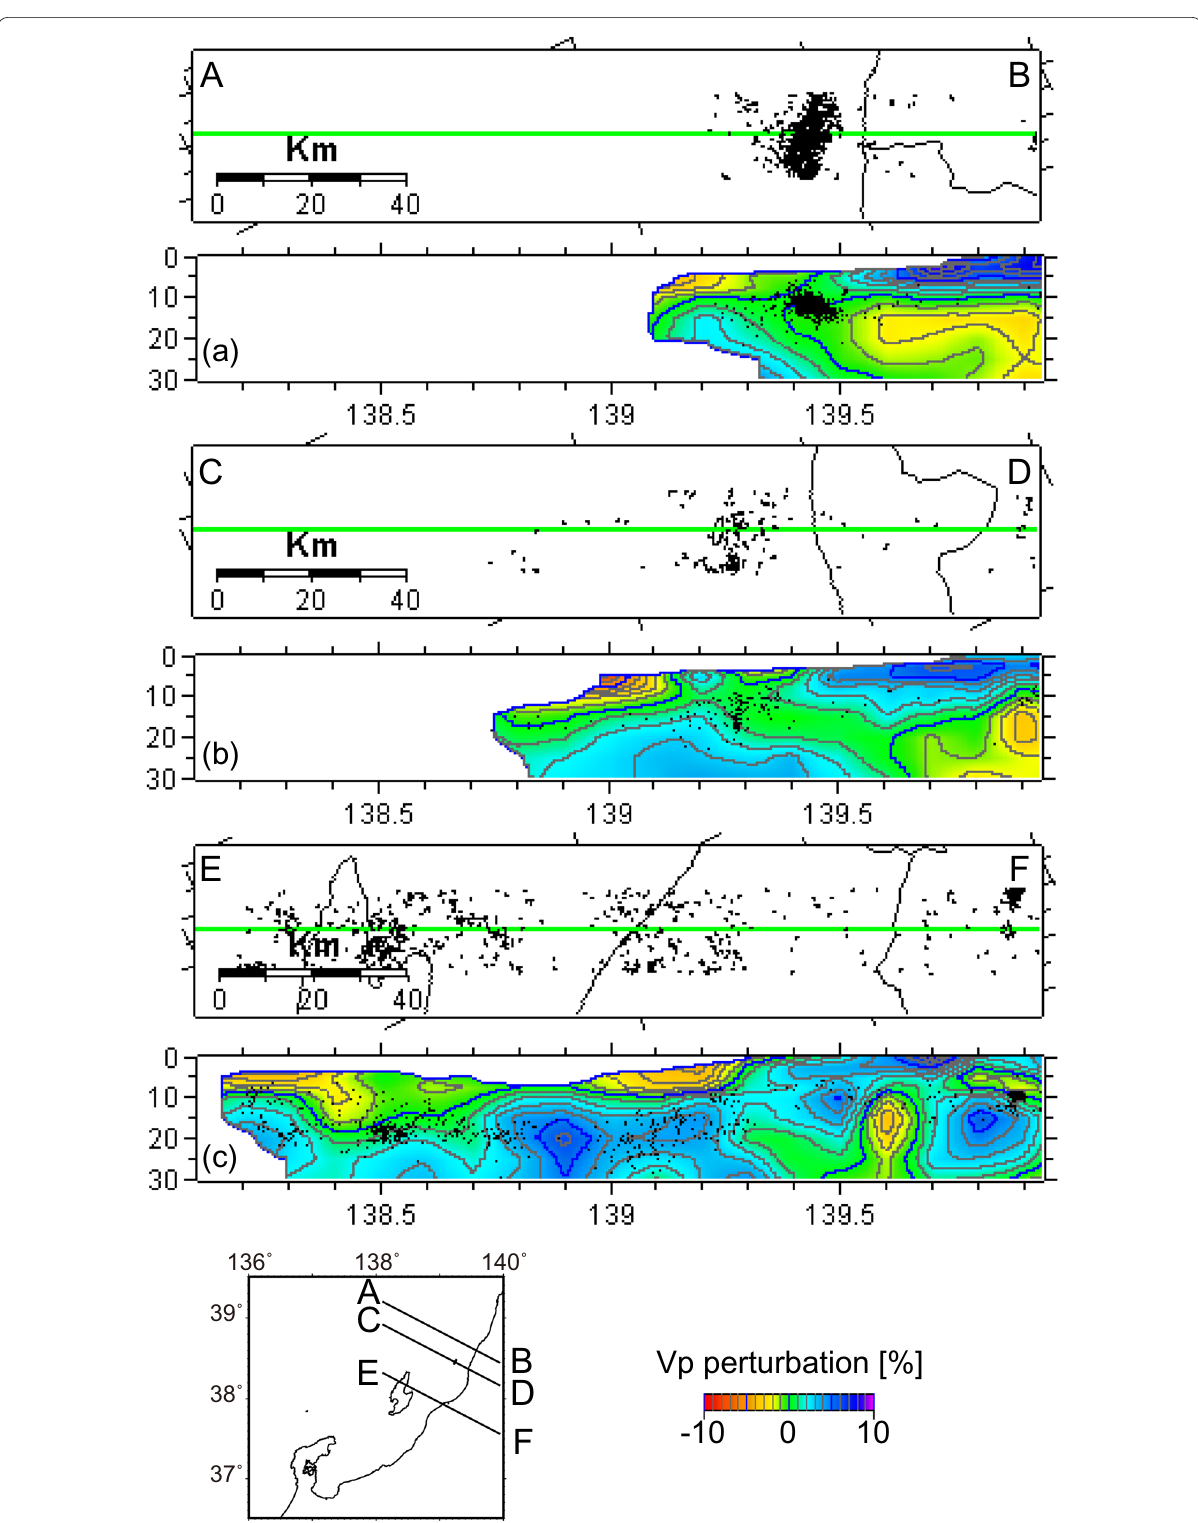
Fig. 24 Vertical cross section across Mogami Trough and rift along the coast of Sea of Japan. a Across the hypocenter of 2019 offshore Yamagata earthquake, b across the Awa Island, and c across the Sado